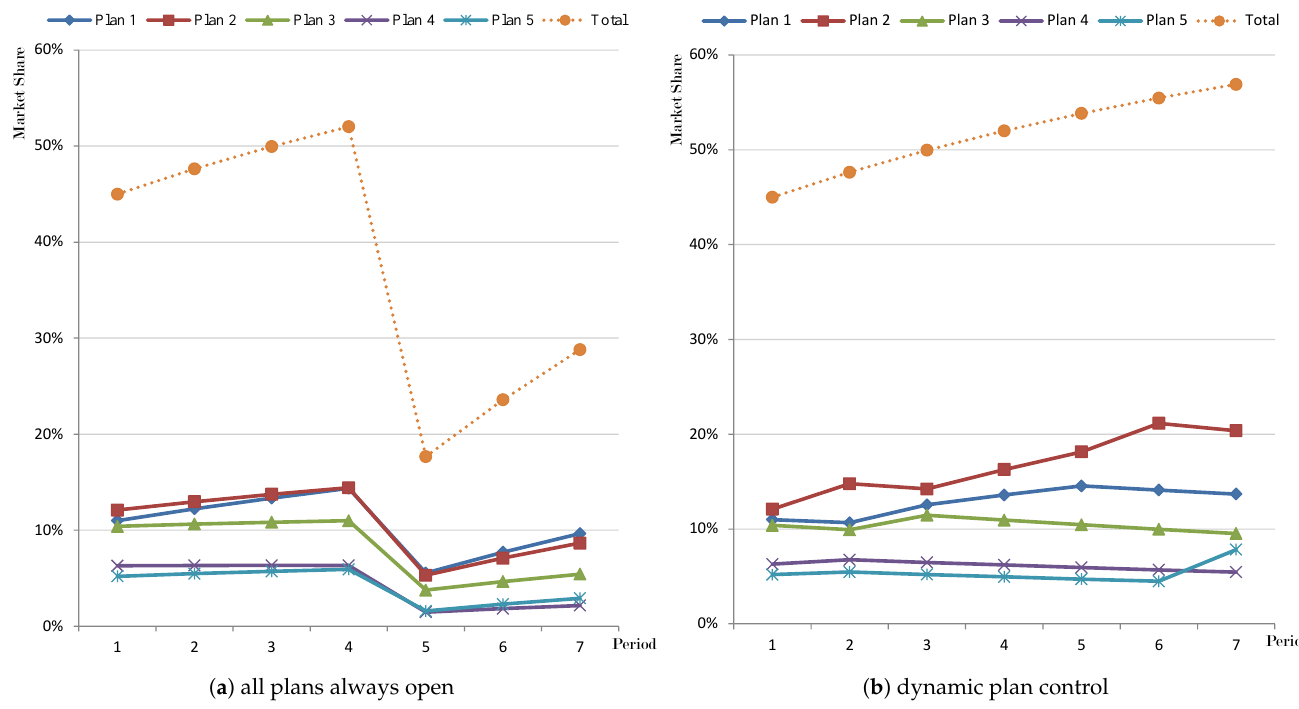
Figure 5. Trends of the market share under APAO and